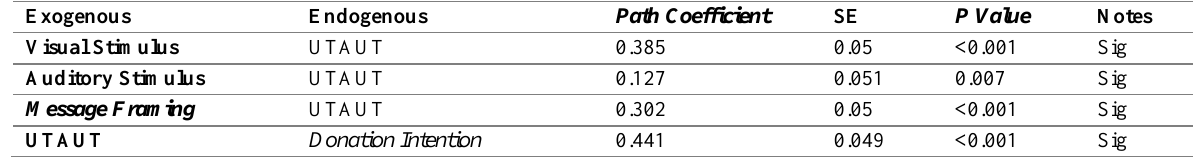
Table 4: Results of Hypothesis Testing for Direct Effect